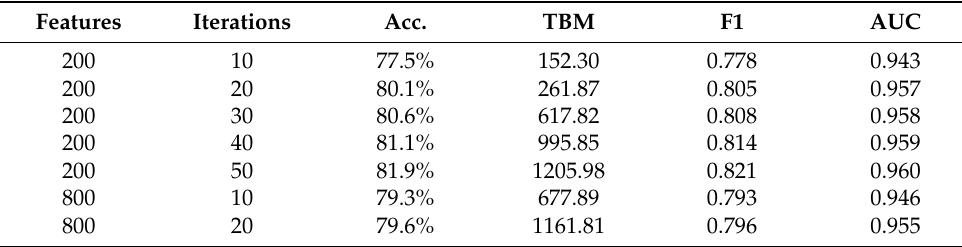
Table 13. Improving accuracy with AdaBoost and RBFN.